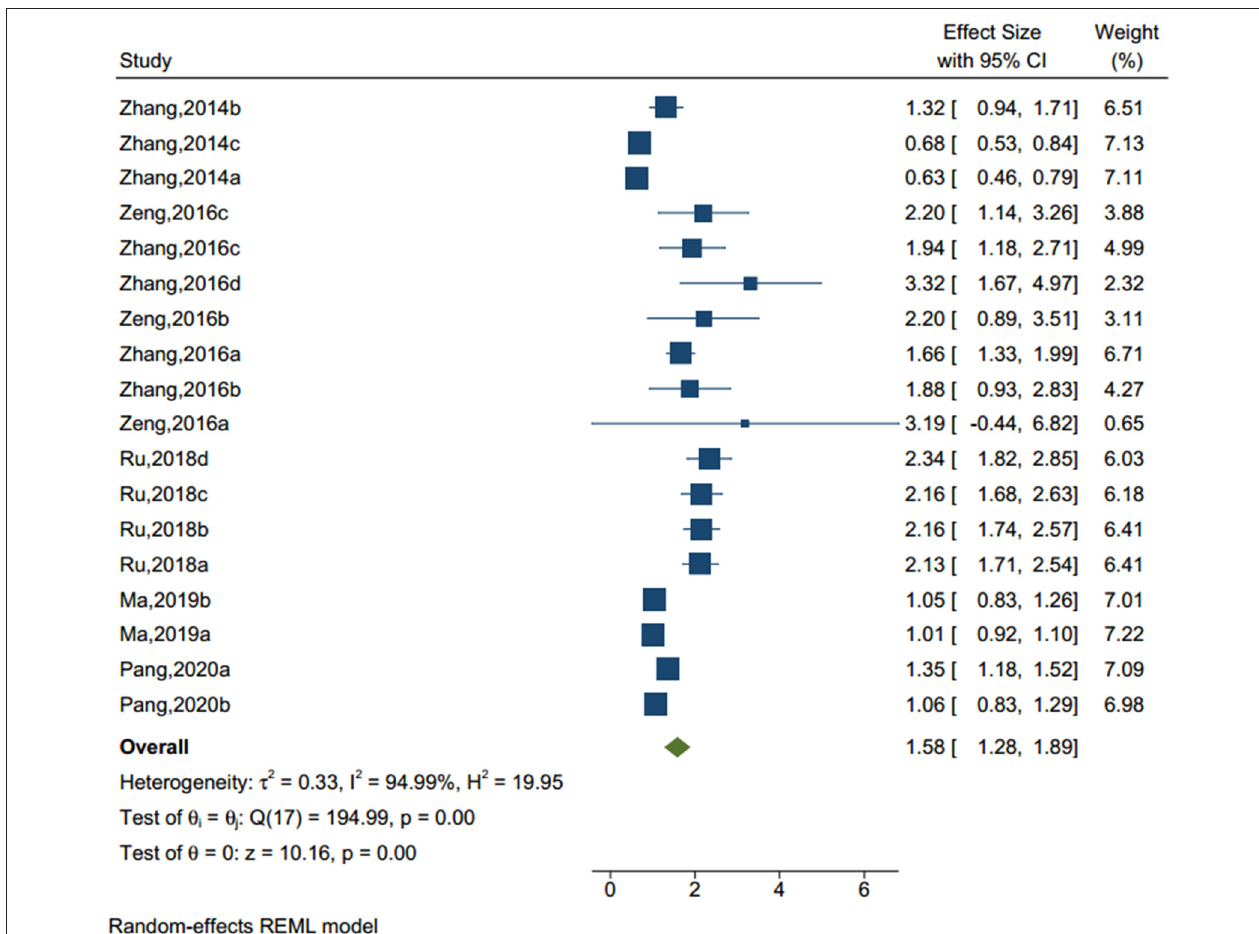
FIGURE 3 | Forest plot of studies including problematic parent-child relationship